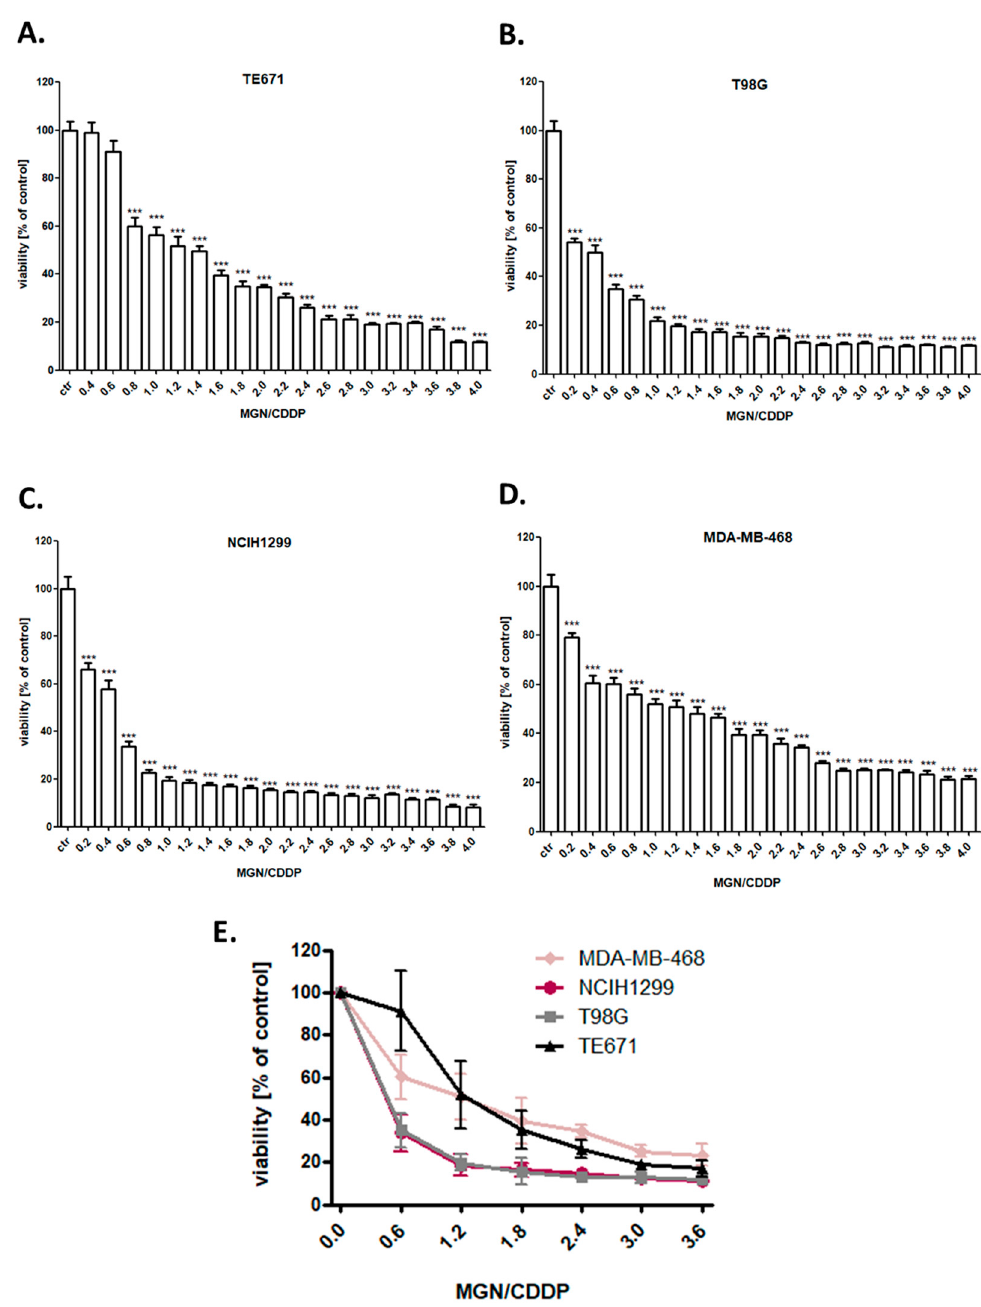
Figure 4. The anti-proliferative e ff ects of combined treatment of magnoflorine (MGN) and cisplatin (CDDP) in ( A ) TE671 ( B ) T98G ( C ) NCIH1299 ( D ) MDA-MB-468 and ( E ) all analyzed cancer cell lines after 96 h treatment with 1:1 drug mixture (MGN / CDDP) in increasing concentrations. Cancer cells were exposed to concomitant MGN and CDDP treatment using di ff erent ratios of the IC 50 (2.0 = IC 50 + IC 50 ). The cell viability was measured by the MTT assay. Results were analyzed using GraphPad Prism 5.0 software (one-way ANOVA; Tukey post-hoc testing). Statistical di ff erences were considered relevant at p < 0.05 (*** p < 0.001). Data are expressed as mean ± standard deviation of the mean ( ± SD); n = 24 per concentration from three independent experiments. 2.3. Influence of MGN, CDDP and Their Combination (at the Fixed Drug Concentration Ratio of 1:1) on the Anti-proliferative Activity of TE671, T98G, NCIH1299, and MDA-MB-468 Cancer Cells